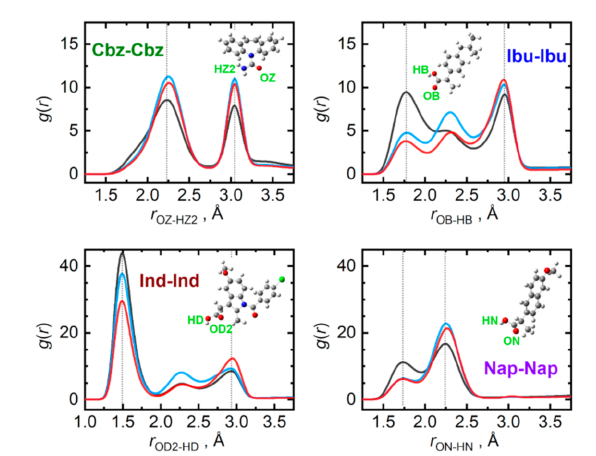
Figure 5. Hydrogen bonding among individual API molecules in the liquid phase at 410 K. Radial distribution functions are given for the most significant contacts in pure API (grey), and their equimolar mixtures with adenine (light blue) and cytosine